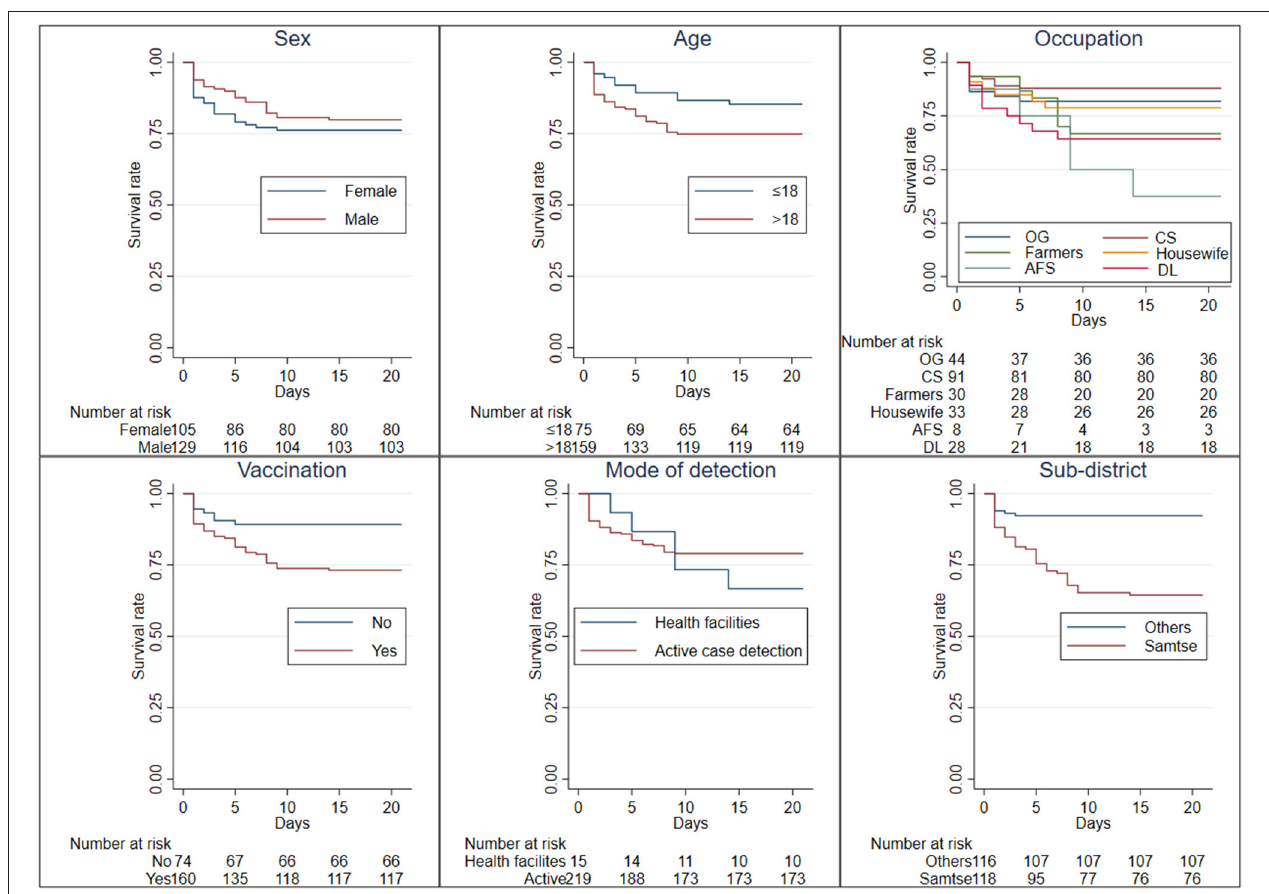
FIGURE 4 | Kaplan-Meier survival estimates for the probability of developing symptomatic COVID-19 in Samtse District, Bhutan. OG, office goers; CS, children/students; AFS, Armed forces and Desuups ; DL, drivers and